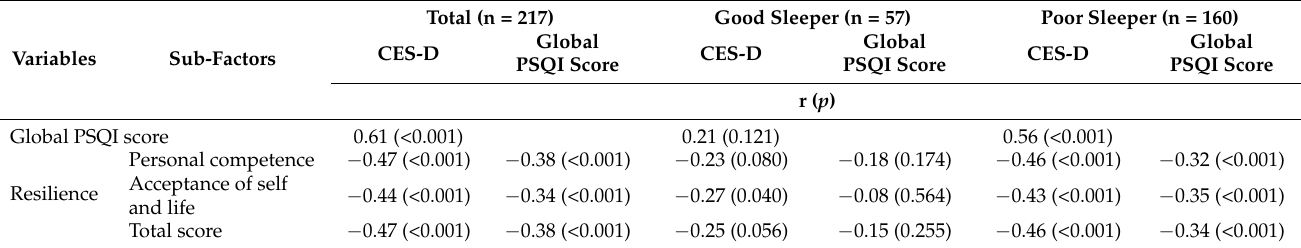
Table 4. Correlations between Variables (n = 217).